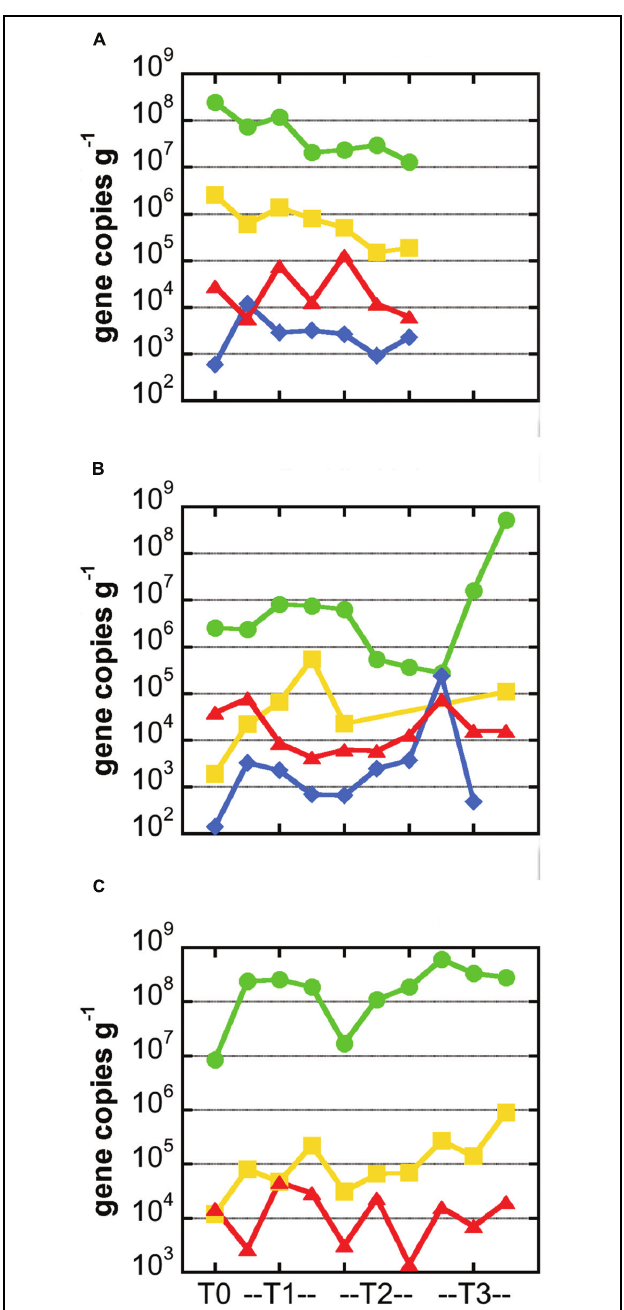
FIGURE 4 | Abundance of carbon cycling functional genes in microbial communities hosted in basalts samples from the Marker 2 (A), Ula Nui (B), and JdF2009 (C) sample sets. In all panels, gene abundance for each sample is presented as number of gene copies per gram of rock. Green circles: bacterial 16S rRNA gene; yellow squares: RuBisCO form II gene cbbM from Calvin Benton Bassham pathway; red triangles, methyl coenzyme M reductase gene mcrA from methane cycling pathways; blue diamonds, ATP citrate lyase gene aclB from reverse TCA process. Note missing symbols in (A) indicate samples that were not available for analysis, while missing symbols in (B,C) indicate values that were not above the limit of detection ( ∼ 10 3 gene copies per gram for cbbM and ∼ 10 2 gene copies per gram for aclB ). Lines connecting symbols are for esthetic purpose and convey no